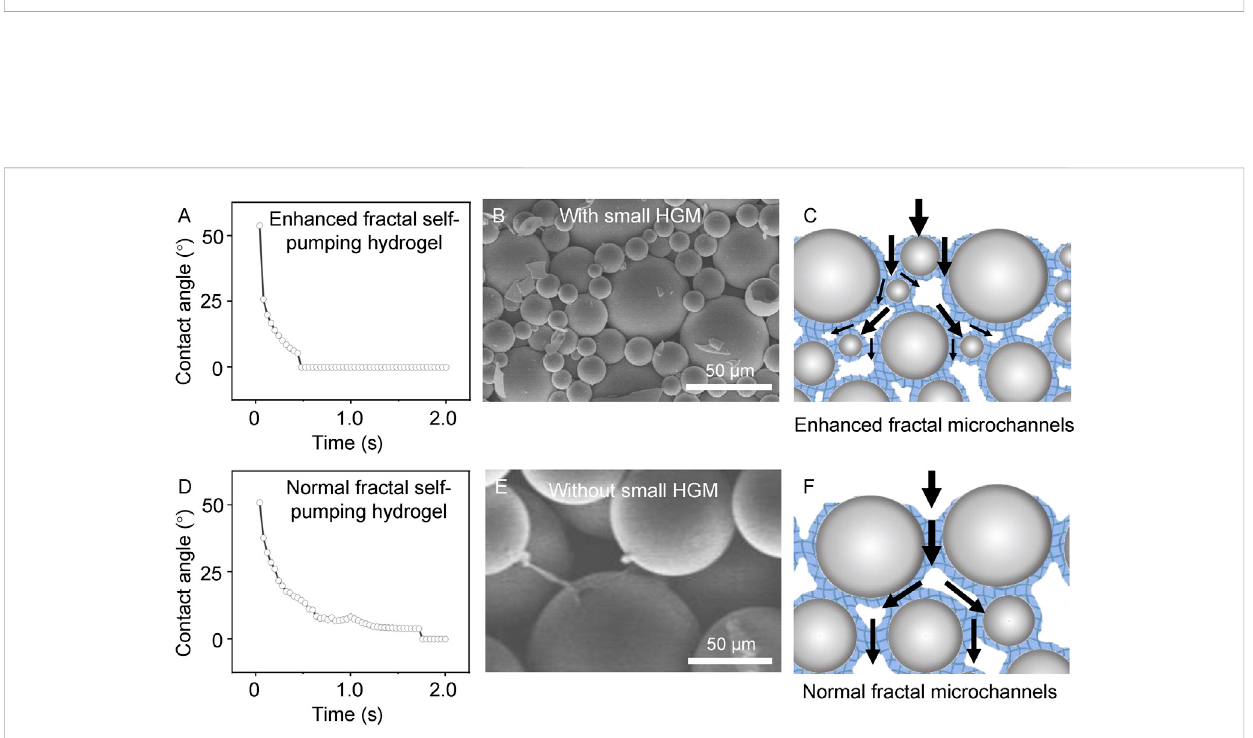
FIGURE 3 Comparison of the EFS hydrogel (A – C) and normal fractal self-pumping hydrogel (D – F) without enhanced fractal microchannels in absorption rate (A, D) , structure (B, E) , and draining model (C, F) .